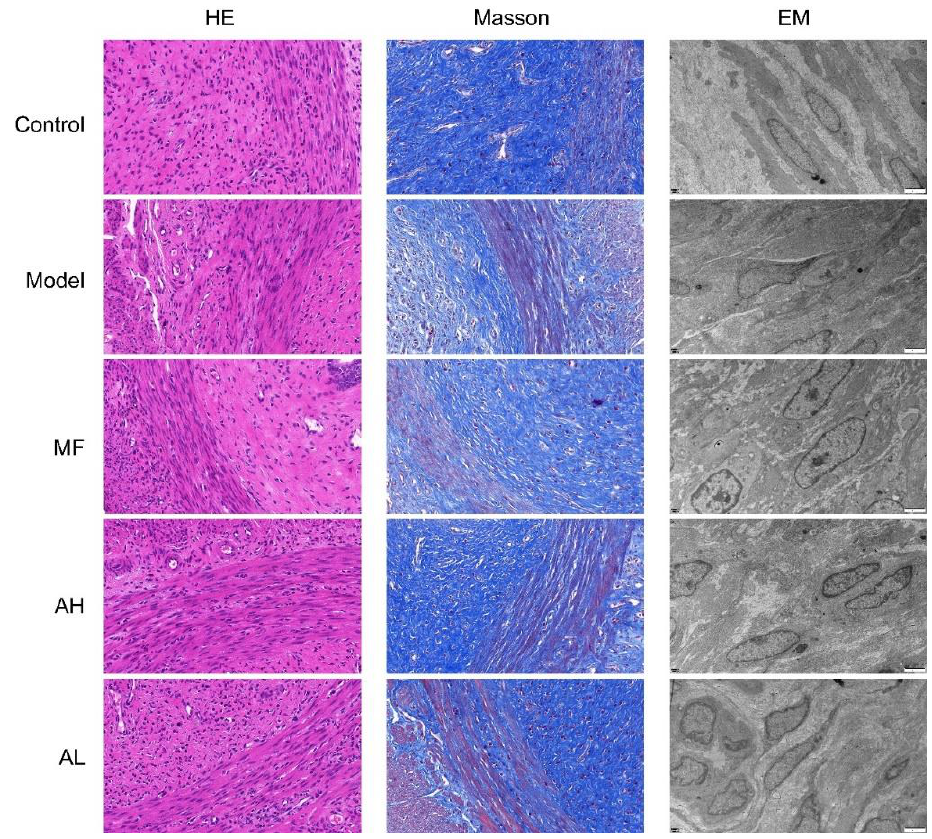
Figure 8. Pathological image of uterus smooth muscle tissue. HE: hematoxylin-eosin staining (×200), Masson (×200), EM: electron microscope (×8000).